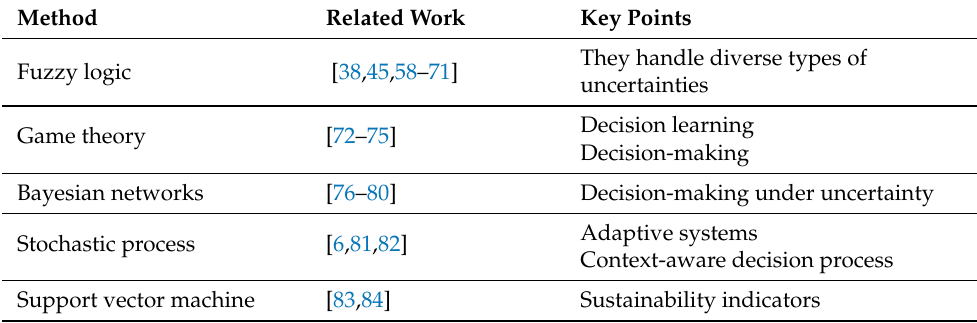
Table 3. Review of optimization